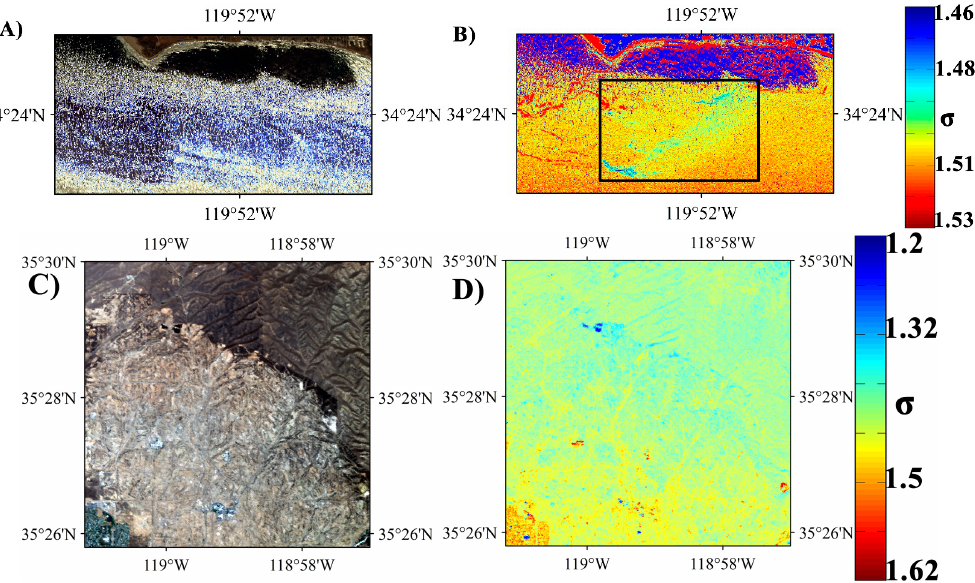
Figure 1. ( A ) True color imagery of Airborne Visual Infrared Imaging Spectrometer-Classic (AVIRIS-C) data acquired on 19 June 2008. ( B ) Band ratio (σ) of at - sensor reflectance (ρ t ) for the 2298 and 2058 nm bands, σ = ρ t (2298)/ ρ t (2058) for AVIRIS-C data in ( A ), black rectangle outline shows clear plume structure. ( C ) True color imagery of AVIRIS-C data acquired on 6 June 2013. ( D ) σ for AVIRIS-C data in ( C ). Data key on figure.